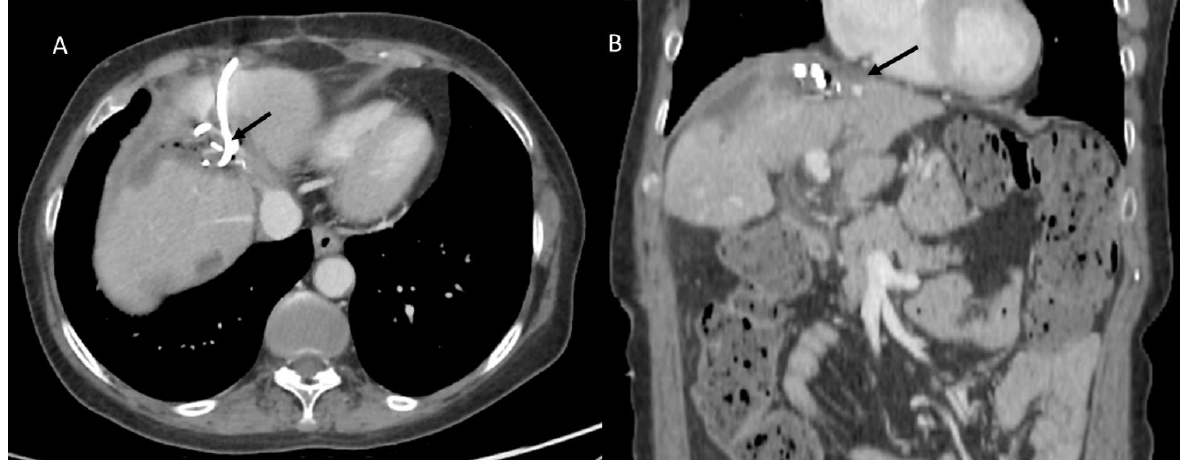
Figure 4. CT-guided hepatic infected biloma drainage (arrows) and postprocedure assessment in portal phase of contrast study in axial ( A ) and coronal ( B ) plane.